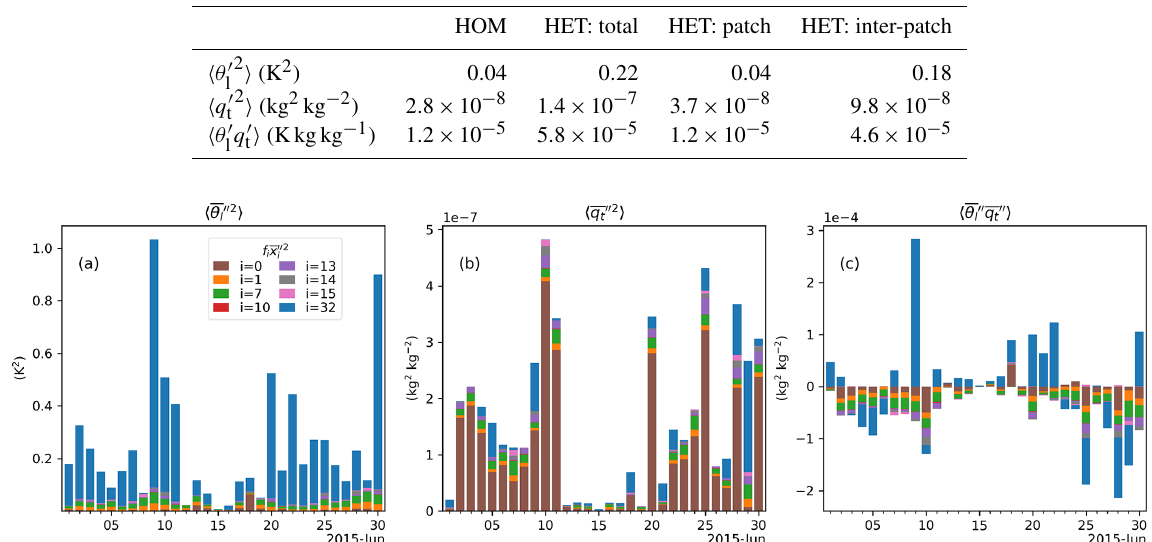
Table 2. Patch means of the variances and covariance of temperature and humidity at the surface. This table lists the mean quantities averaged over the JJA season in 2015. The first column (HOM) is derived from the default CLUBB approach using the grid-cell average fluxes provided by ELM. The second column shows the HET-computed surface moments using the subgrid-scale fluxes and states from individual ELM patches. Following Eqs. (7)–(9), the addition of the last two columns is equivalent to the value of the HET: total column.